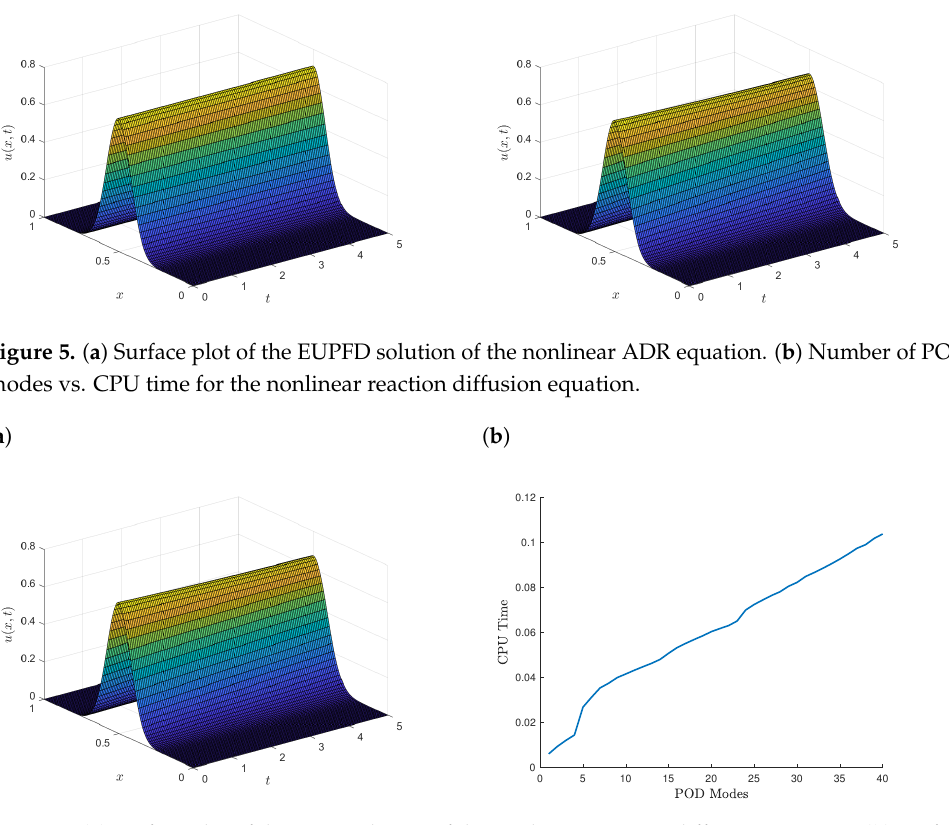
Figure 6. ( a ) Surface plot of the exact solution of the nonlinear reaction diffusion equation. ( b ) Surface plot of the UPFD solution of the nonlinear reaction diffusion